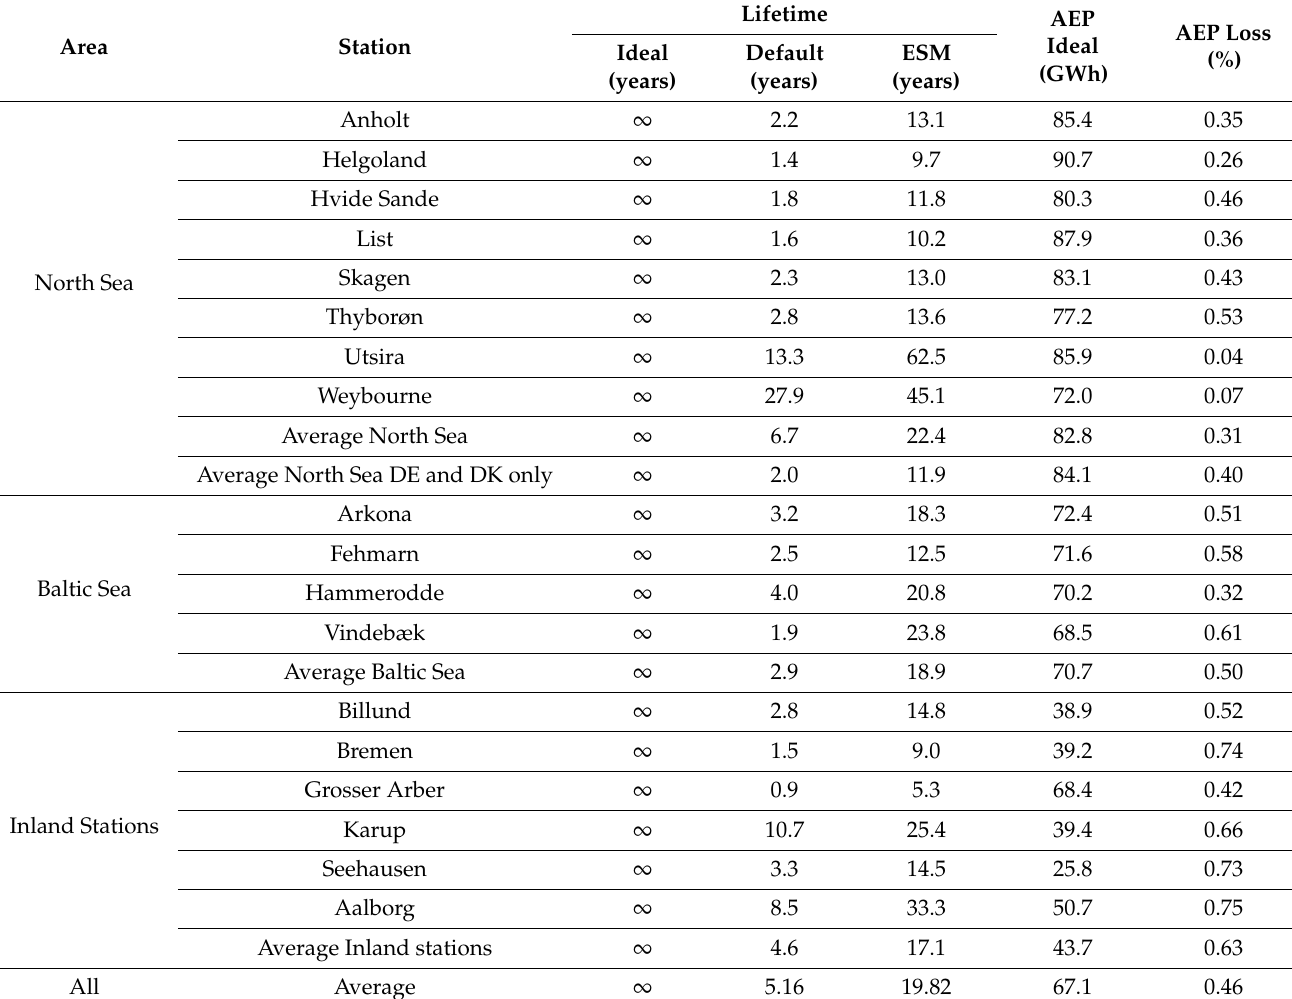
Table 2. Calculated lifetime for each station for three cases: Ideal, default, and erosion-safe mode (ESM) operation. ESM is calculated with the same threshold values for all stations. Annual Energy Production (AEP) (in GWh) for ideal blades and AEP loss (in %) between ideal blades and default operation are listed.